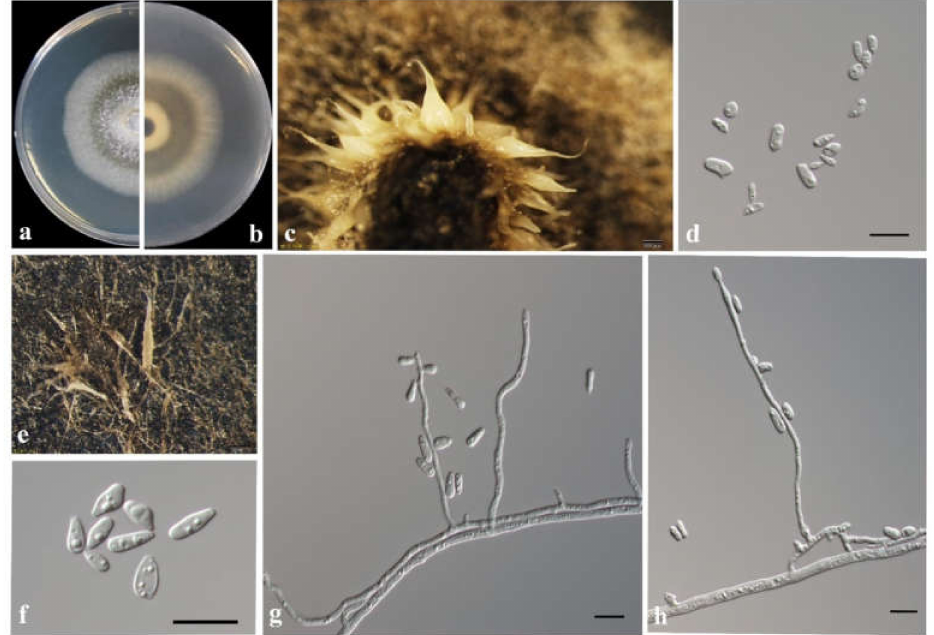
Figure 11. Morphological characteristics of Ophiostoma shennongense . ( a , b ) Upper and reverse cultures on 2% MEA 10 days after inoculation. ( c , e ) Brush-shaped conidiomata. ( d , f – h ) Conidiogenous cells of hyalorhinocladiella-like asexual state and conidia. Scale bars: ( c , e ) =20 µ m; ( d , f – h ) =10 µ